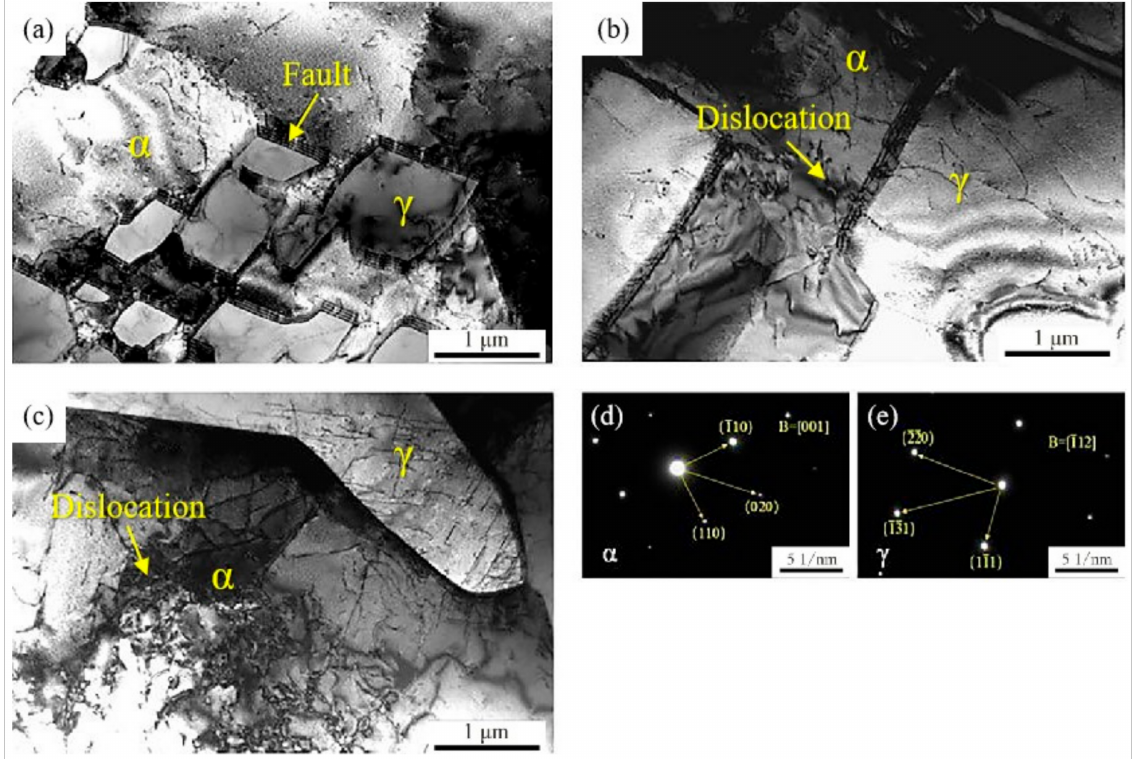
Figure 4. TEM images of DSS 2205 solid wire MIG welding joints prepared in different shielding gases. ( a ) Ar; ( b ) 98%Ar + 2%O 2 ; ( c ) 98%Ar + 2%N 2 ; ( d ) ferrite diffraction pattern; ( e ) austenite diffraction